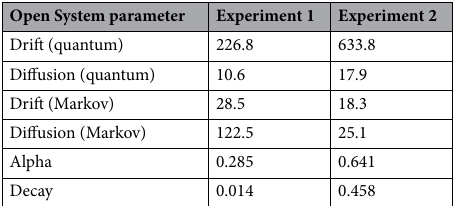
Table 3. Parameter estimates for the open system model presented here (right panels of Fig.